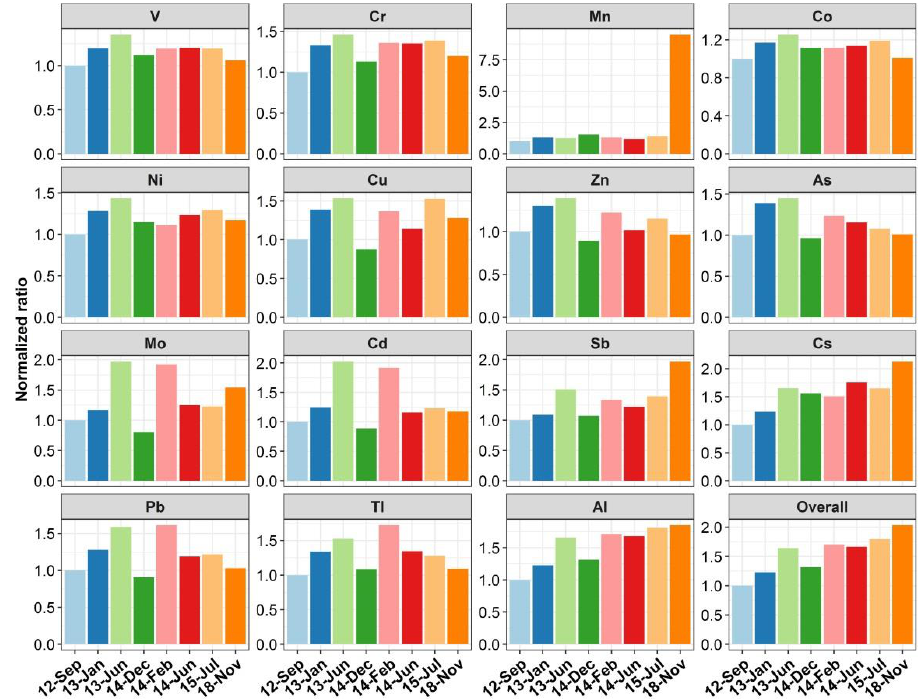
Figure 5. Temporal variations of MMEs in JRE sediments. The concentrations of MMEs from different sampling times were normalized with those from the first sampling time.